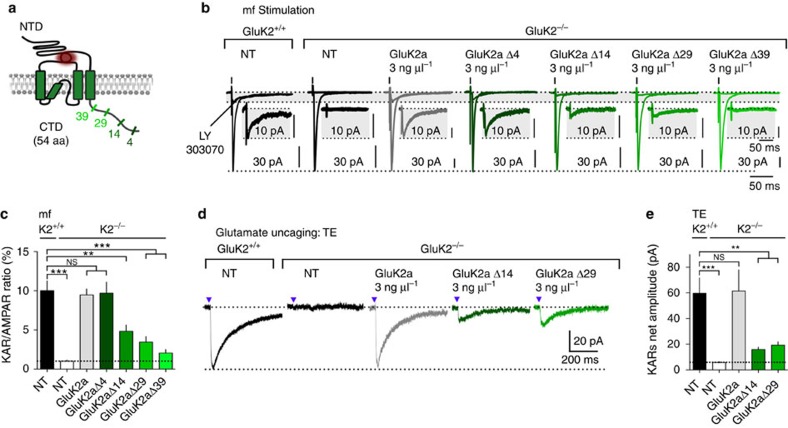
GluK2a C-terminal sequence is necessary for stabilization of synaptic KARs.(a) Schematic representation of the GluK2a subunit, illustrating the sites at which the CTD was truncated. (b,c) Sample traces illustrating synaptic currents evoked by mf stimulation in organotypic slices prepared from GluK2+/+ and GluK2−/− mice, not transfected (NT) or transfected with 3 ng μl−1 of wt or mutated GluK2a cDNA (Δ4, Δ14, Δ29 and Δ39). Experiments were performed in the presence of bicuculline (10 μM), D-AP5 (50 μM) and NBQX (150 nM). Traces represent the average of synaptic currents evoked at 3 Hz in the absence and in the presence of 25 μM LY303070, to isolate the AMPAR and the KAR component, respectively. In the insert are shown enlargements, by the same proportion, of isolated KAR-EPSCs. (c) Bar graphs summarizing KAR/AMPAR ratios obtained from the experiments presented in b. GluK2+/+ NT: n=8 cells; GluK2−/− NT: n=8; GluK2−/−+GluK2a: n=9 cells; GluK2Δ4: n=12 cells; GluK2Δ14: n=7 cells; GluK2Δ29: n=12 cells; GluK2Δ39: n=8 cells. 40 mice. (d,e) Sample traces illustrating KAR-currents evoked by glutamate uncaging on TEs of CA3 PCs in organotypic slice cultures prepared from GluK2+/+ and GluK2−/− mice, not transfected (NT) or transfected with 3 ng μl−1 of wt or mutated GluK2a cDNA (Δ14 and Δ29). (e) Bar graphs summarizing KAR/AMPAR ratios obtained from the experiments presented in d. GluK2+/+ NT: n=11 cells; GluK2−/− NT: n=11; GluK2−/−+GluK2a: n=9 cells; GluK2Δ14: n=11 cells; GluK2Δ29: n=15 cells; 24 mice. In all panels, values are presented as mean ±s.e.m. of n experiments. Data were compared using one-way analysis of variance followed by Dunnett's multiple comparison test (NS, not significant; P>0.05, **P<0.01 and ***P<0.001).